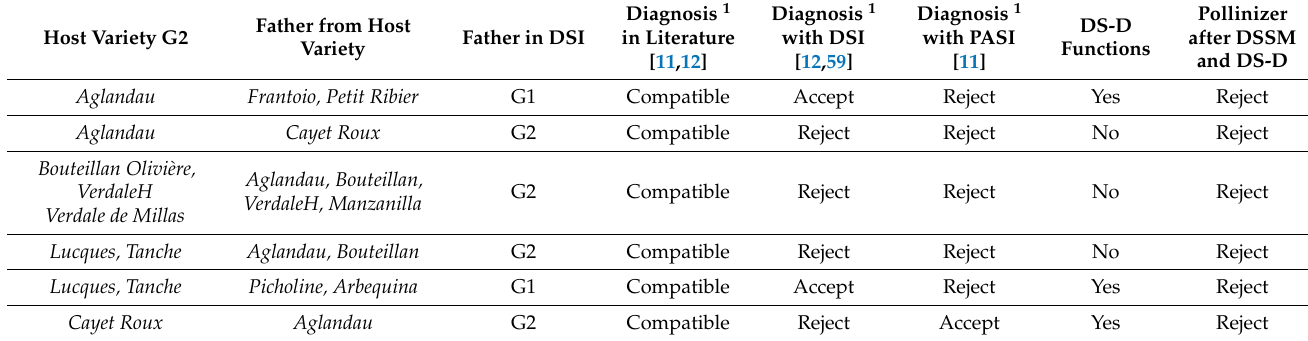
Table 6. Paradoxical diagnosis from paternity tests for different pairwise combinations of varieties in the literature, where DSI and PASI are explained by the dual-successive-screen model (DSSM) with or without degradation of S-determinants